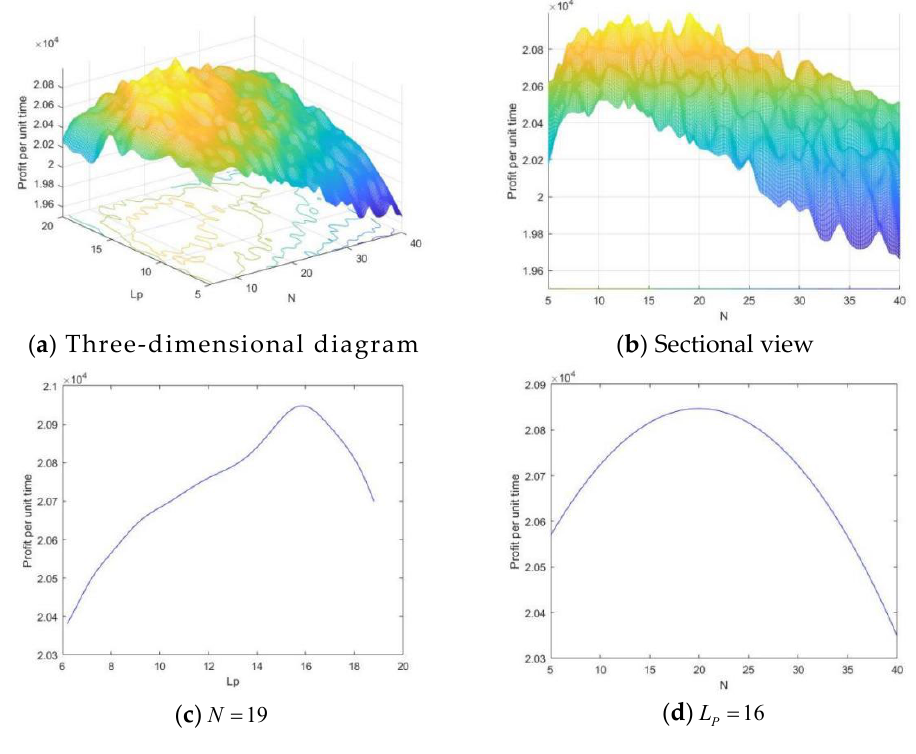
L by the model. Figure 2. The profit per unit time as a function of N and L p p by the model.